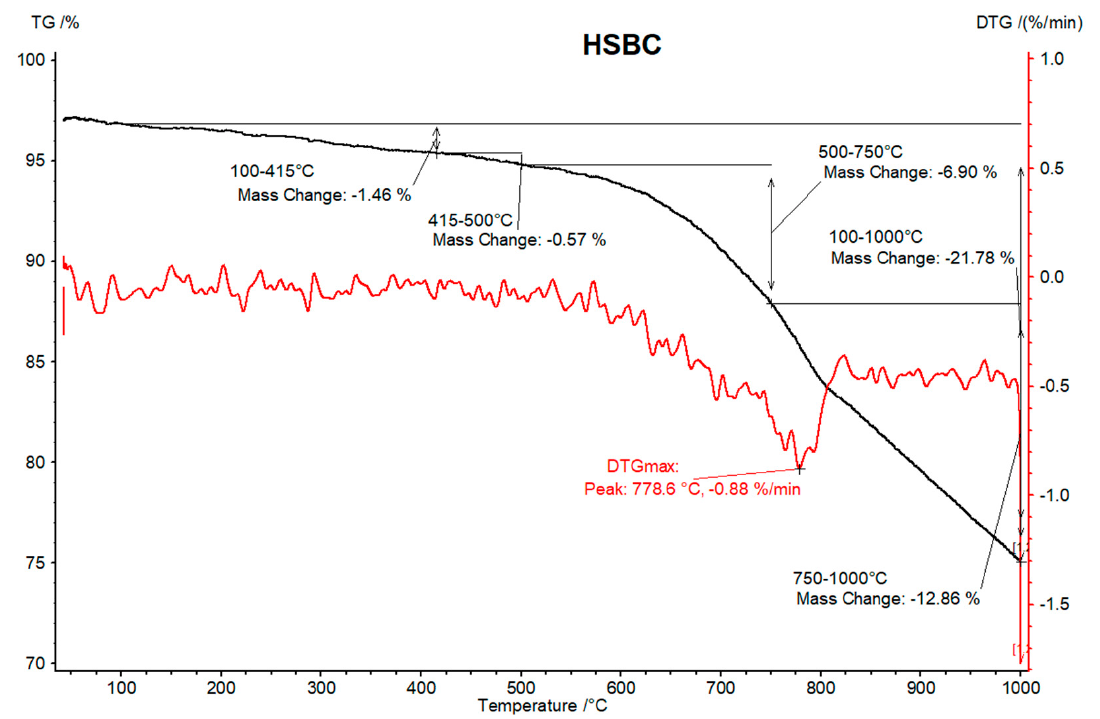
Figure A9. TG/DTG curves obtained for olive kernel biochar.